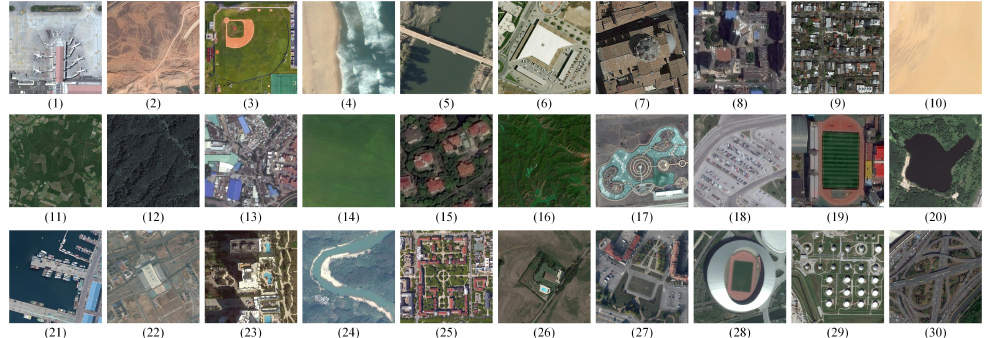
Figure 6. Examples of the AID dataset. (3) NWPU-RESISC45 dataset: This dataset is more complex and challenging compared with the above three datasets. It contains a total of 31,500 images divided into 45 different scenes. Each scene has 700 images with an image size of 256 × 256 pixels. Because of the more diverse scenes, the spatial resolution of the images varies from 0.2 m to 30 m. Figure 7 shows some examples of this dataset.